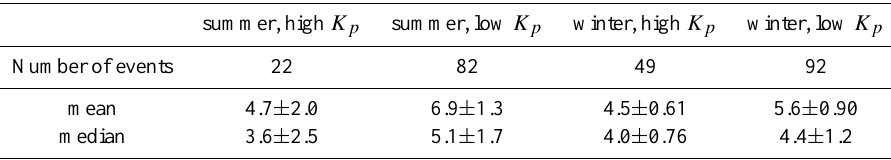
Table 3. Mean and median scale sizes in km for the electric field, S(E) , separated for summer and winter, and high ( > 3) and low ( ≤ 3) K p . The values are mapped down to ionospheric altitude for reference and given in km. For median and mean values, errors using the 95.5% confidence interval are